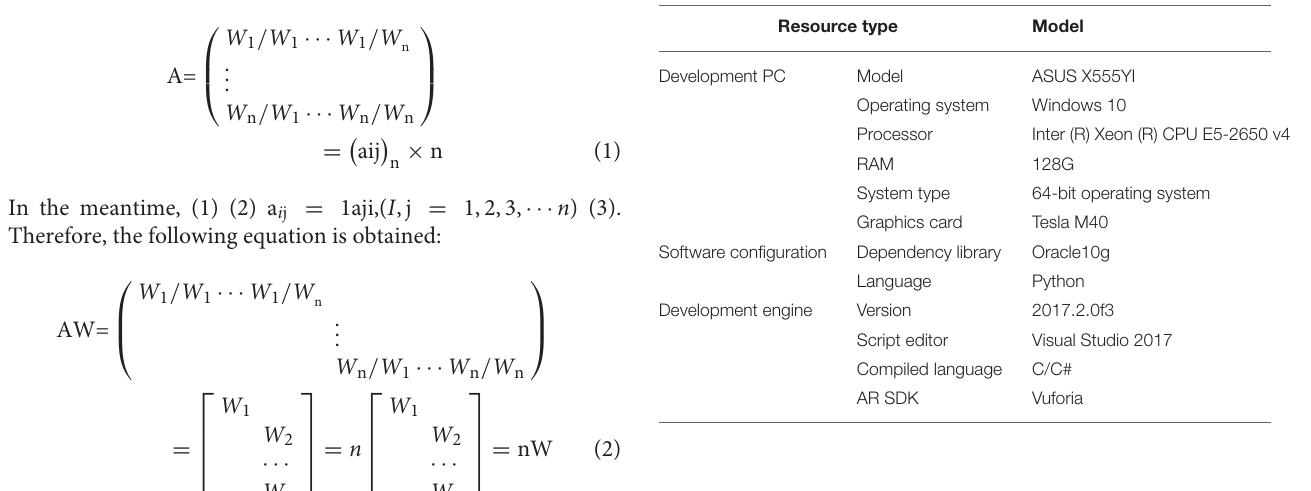
TABLE 2 | Experimental development